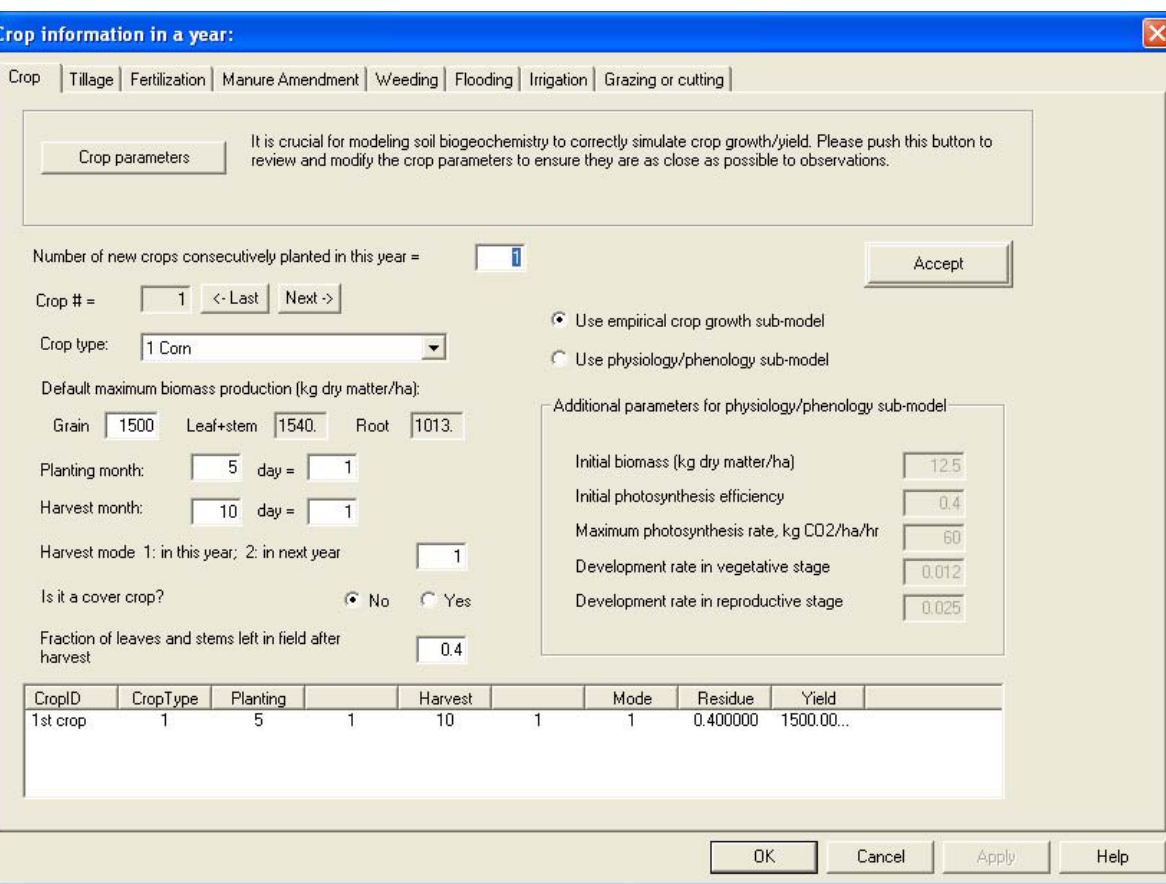
Figure 11. Screenshot of the DNDC model (9.1)